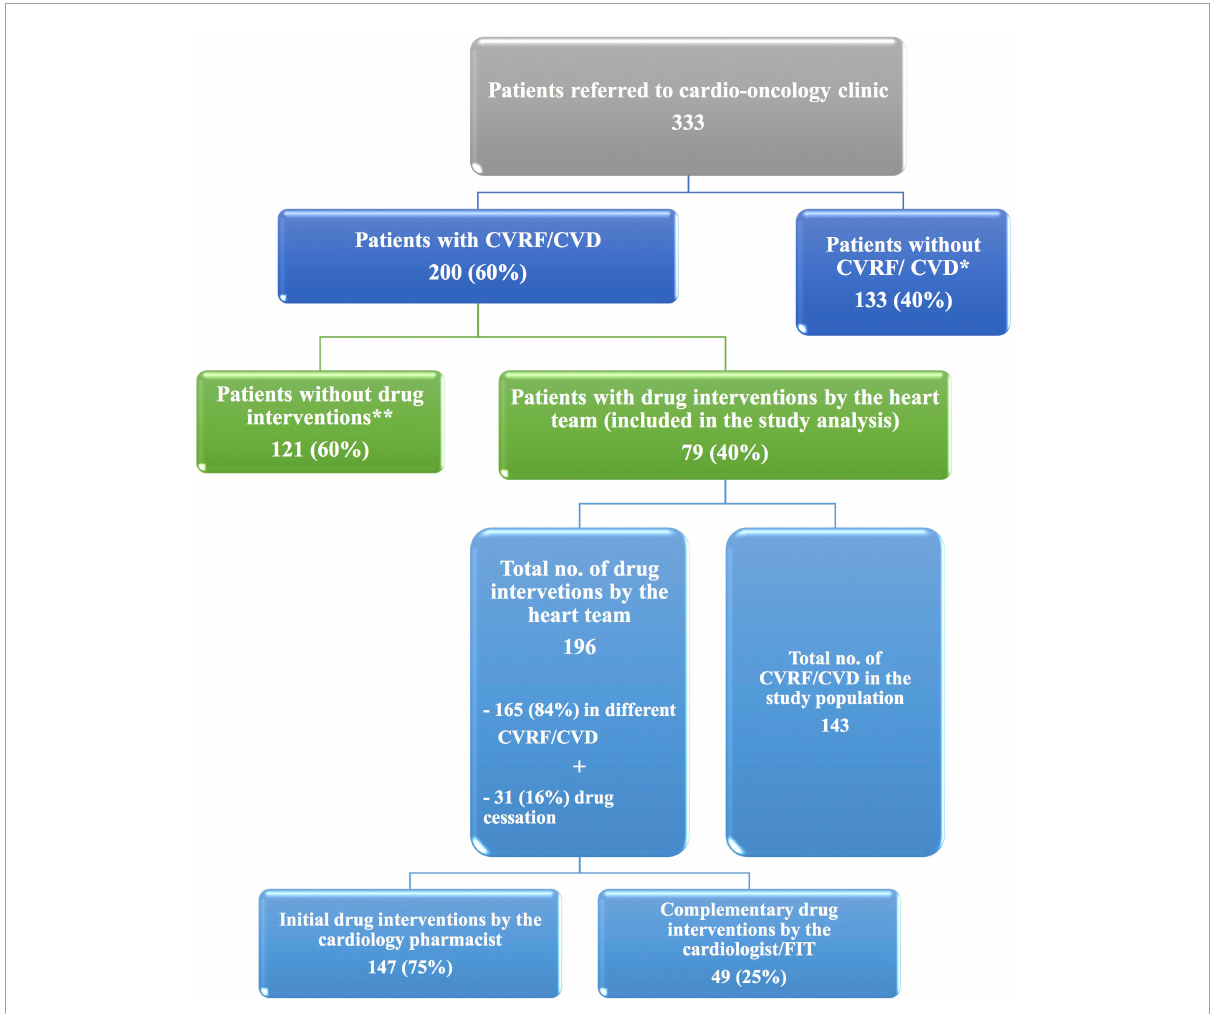
FIGURE2 The ICOP-Pharm study flow diagram. At the cardio-oncology clinic, 200 of 333 patients with cancer had CVD/CVRF. Among patients with CVRF/CVD, drug interventions by the heart team were done for 79 patients who were included in the ICOP-Study analysis. *Patients without CVRF/CVD were referred to the clinic either for baseline echocardiography before starting cardiotoxic cancer therapy or for suspected cardiac disease. **Patients without drug interventions because they did not bring their home cardiovascular drugs and they did not know their medication name. Therefore, drug interventions were not applicable. For those patients, appointments were scheduled for drug optimization. CVD, cardiovascular disease; CVRF, cardiovascular risk factor; and FIT, fellow in